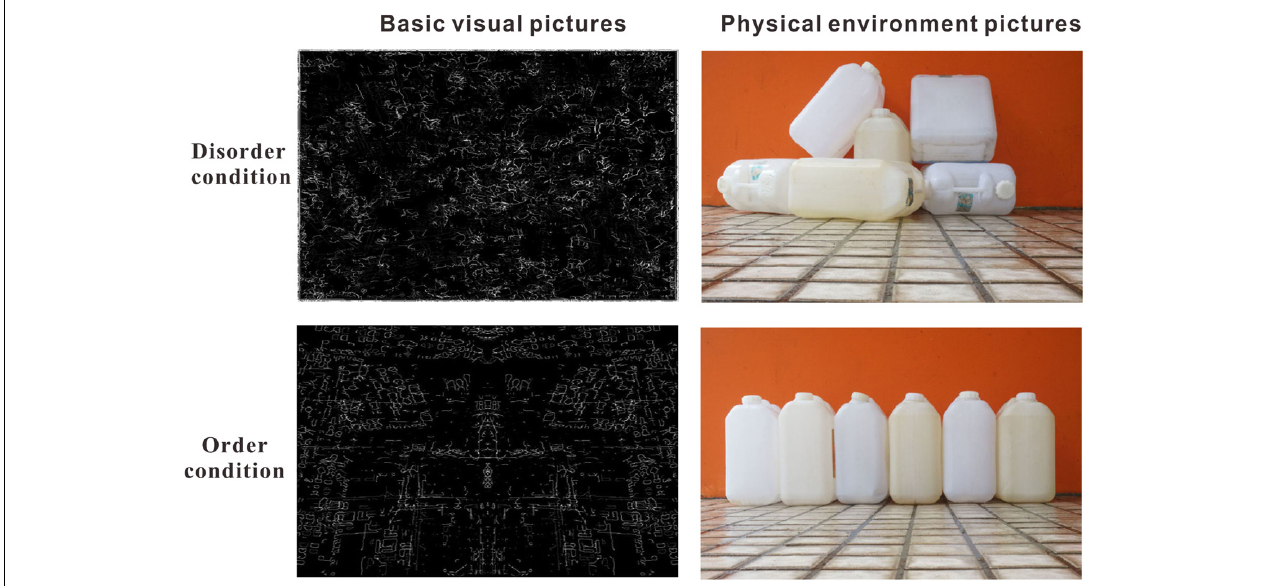
FIGURE 1 | Illustration of the stimuli: basic visual disorder/order pictures and physical environmental disorder/order pictures.